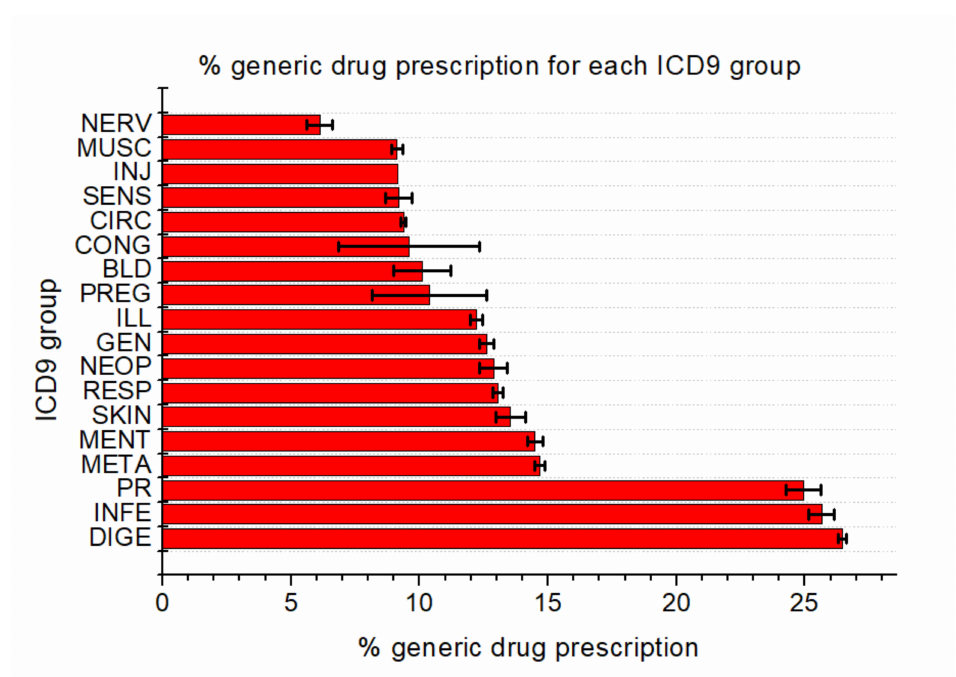
Figure 8. Percentage of generic drug prescriptions within each ICD9 group, with associated statistical